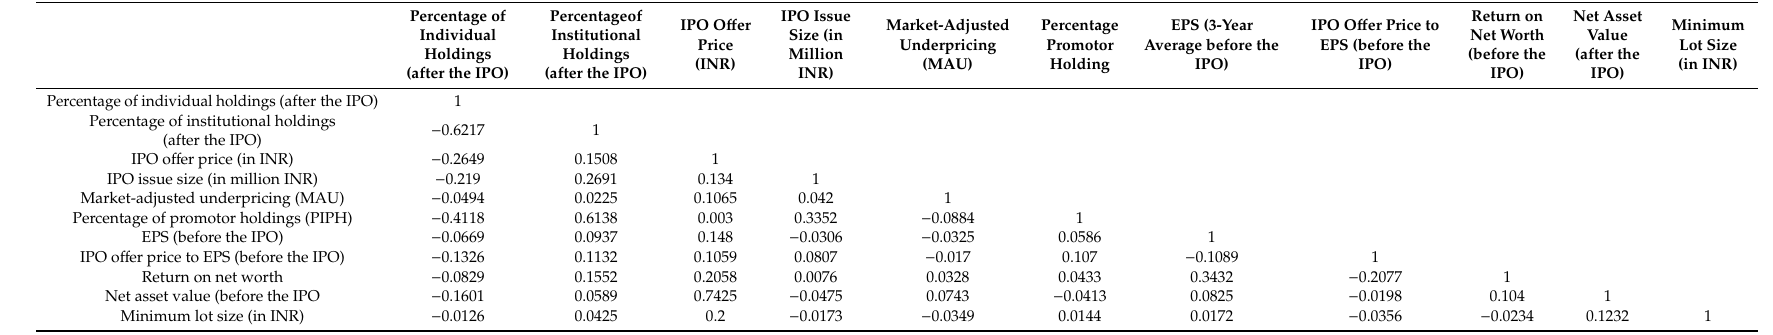
Table 3. Correlation matrix—post-IPO holdings and IPO issue price factors (financial and non-financial).